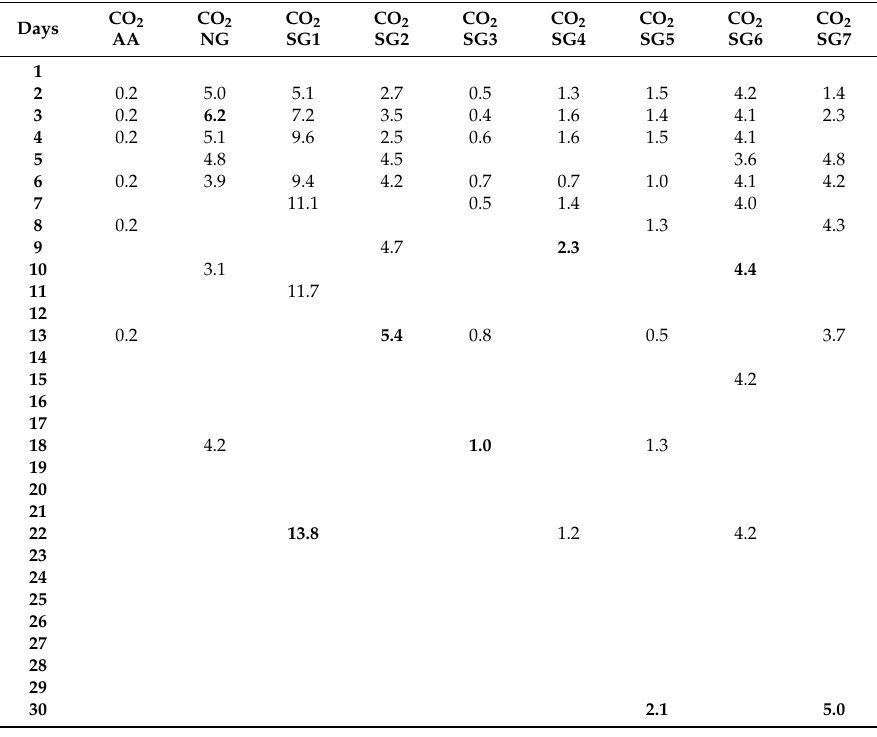
Table A1. Modified Fourier analysis for CO 2 in AA, NG and SG 1-7 (4-W samples). Maxima of amplitude are highlighted in